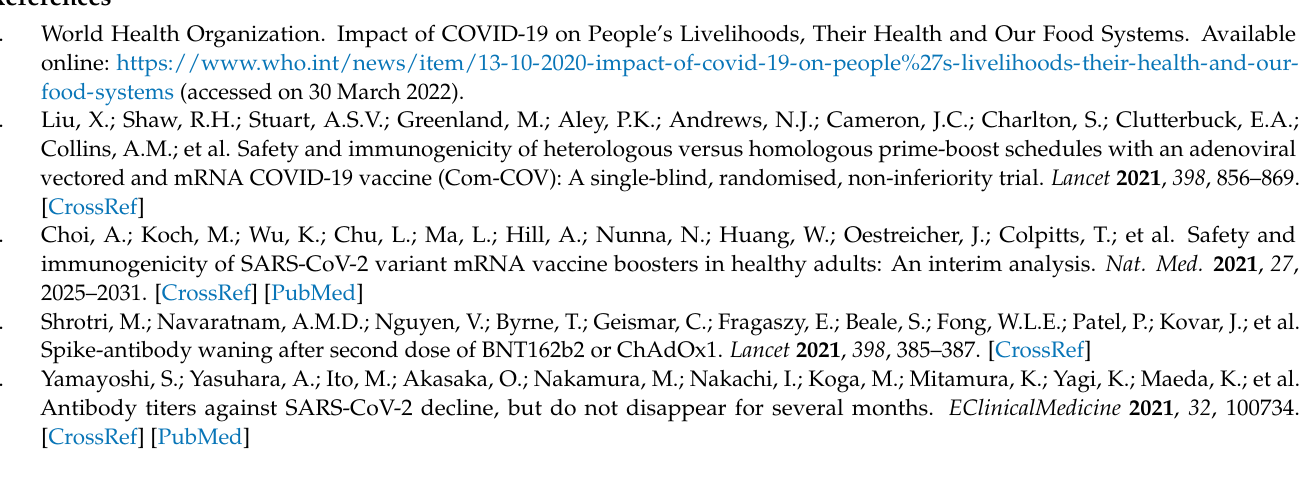
Figure S1: Forest plot of the pooled log-transformed neutralization antibody titers before booster vaccination in different age groups; Figure S2: Forest plot of the pooled log-transformed neutralization antibody titers after homologous booster vaccination; Figure S3: Forest plot of the pooled log- transformed anti-RBD IgG after homologous booster vaccination; Figure S4: Forest plot of the pooled log-transformed neutralization antibody titers after heterologous booster vaccination; Figure S5: Forest plot of the pooled log-transformed anti-RBD IgG after heterologous booster vaccination; Figure S6: Forest plot of the pooled log-transformed neutralization antibody titers before and after homologous booster vaccination in different age groups; Figure S7: Forest plot of the pooled log- transformed neutralization antibody titers before and after heterologous booster vaccination in different age